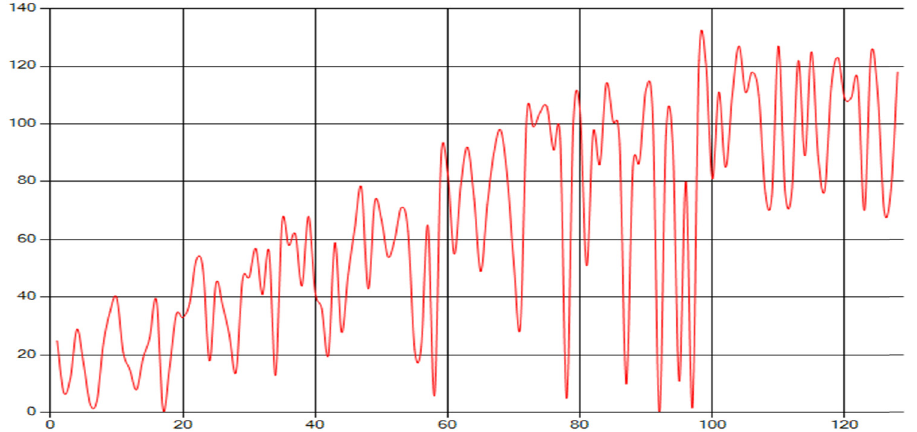
Figure 11: The location of halftone cell q [ 4,4 ] based on